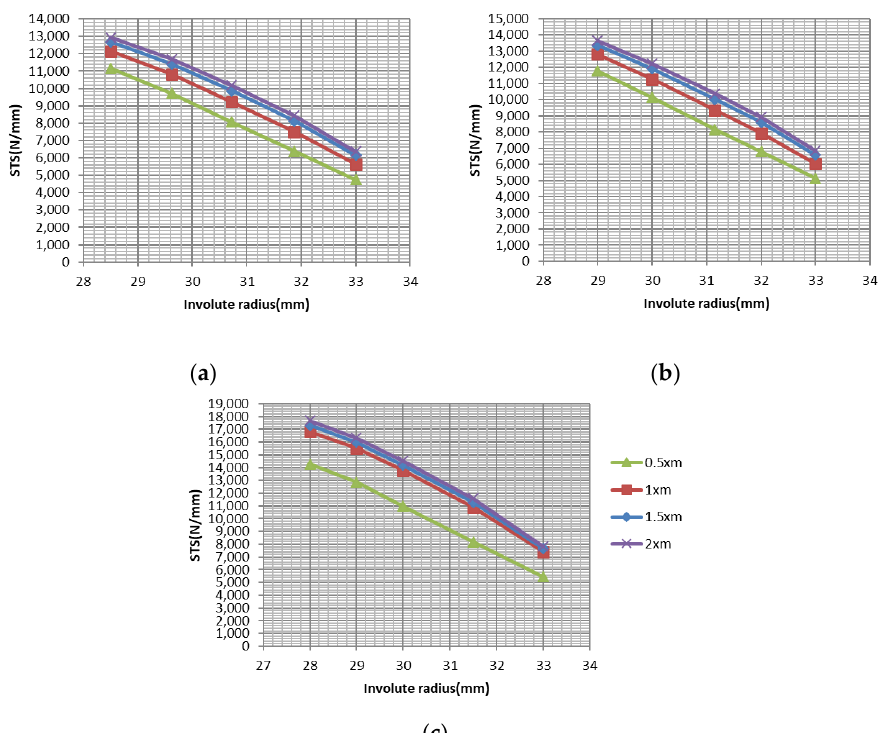
Figure 23. STS results of hybrid gears with different DSPAs; ( a ) 20°, ( b ) 25°, ( c ) 30°.